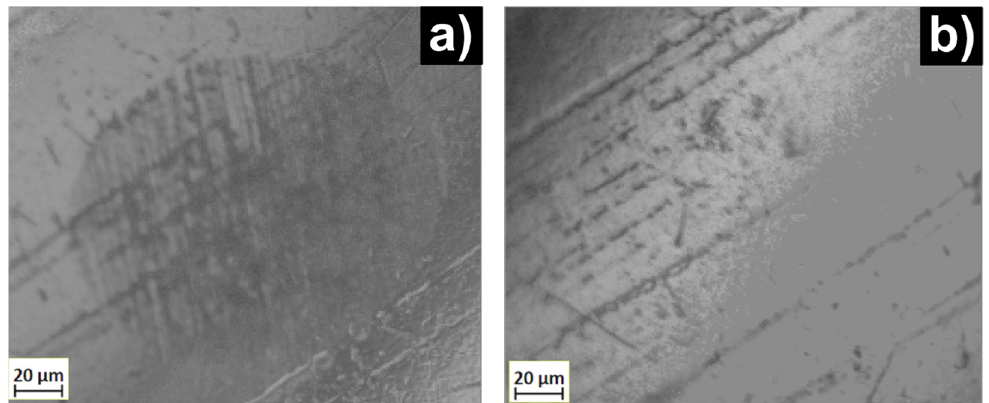
Figure A2. Optical micrographs of worn surfaces of the ISO 100Cr6 ball tested with the mineral oil ( a ) and a natural lubricant (CO/SO 4) ( b ).